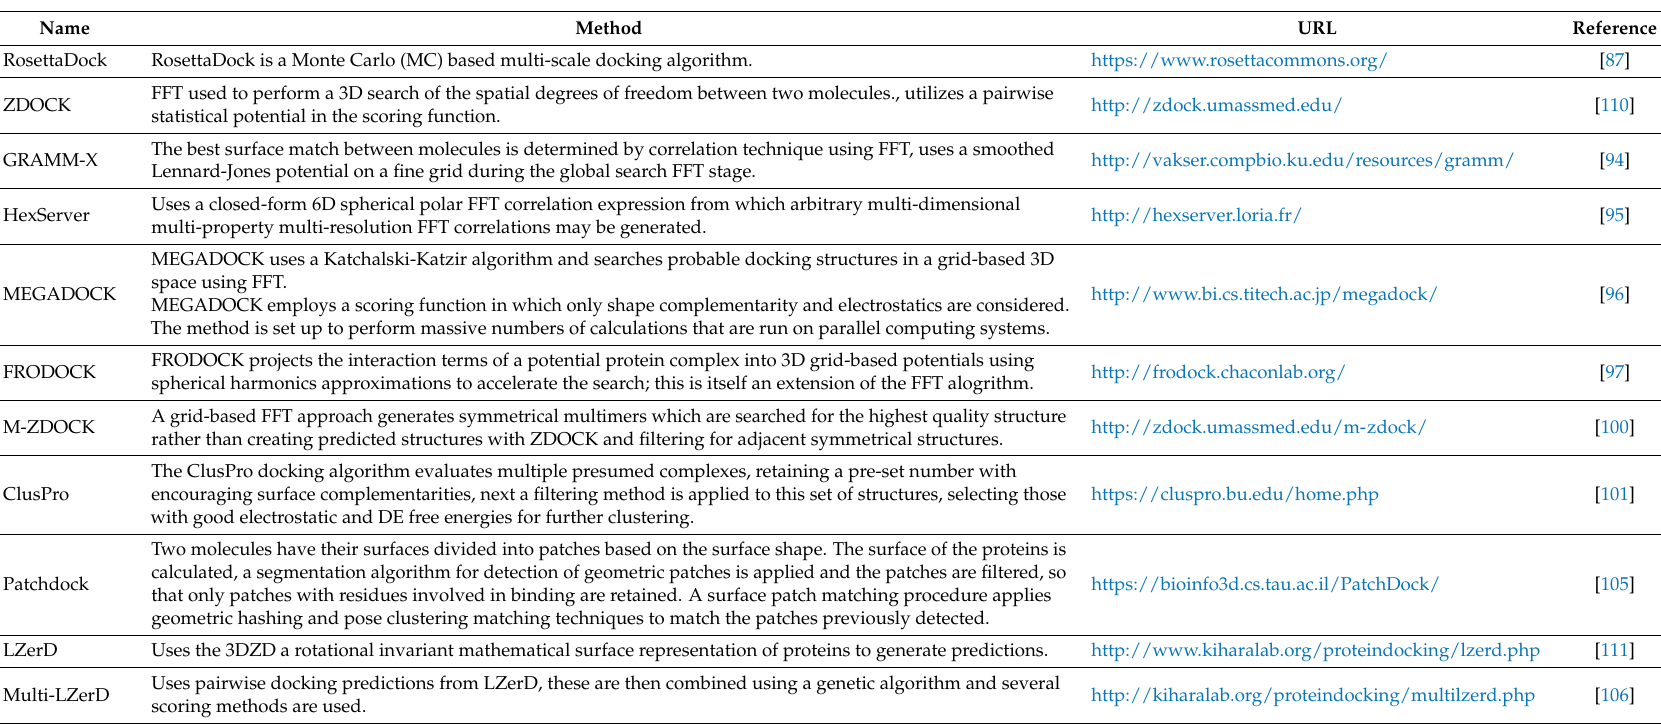
Table 2. Overview of bioinformatics methods for modelling